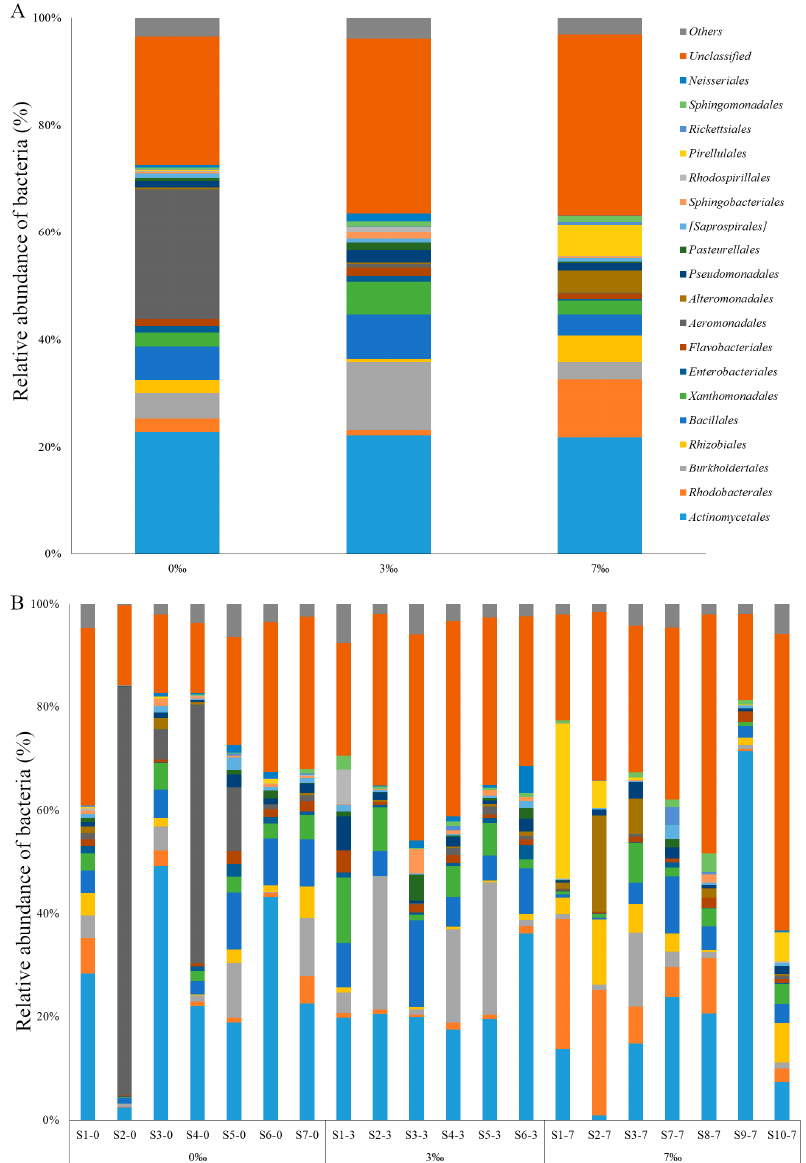
Figure 5. Relative abundance (%) of the most prevalent bacterial orders in three groups kept at different levels of salinity ( A ) and in individual pike ( B ). Figures show all orders with an abundance > 2.5%. Orders with an abundance ≤ 2.5% are pooled and labeled as “Others”.